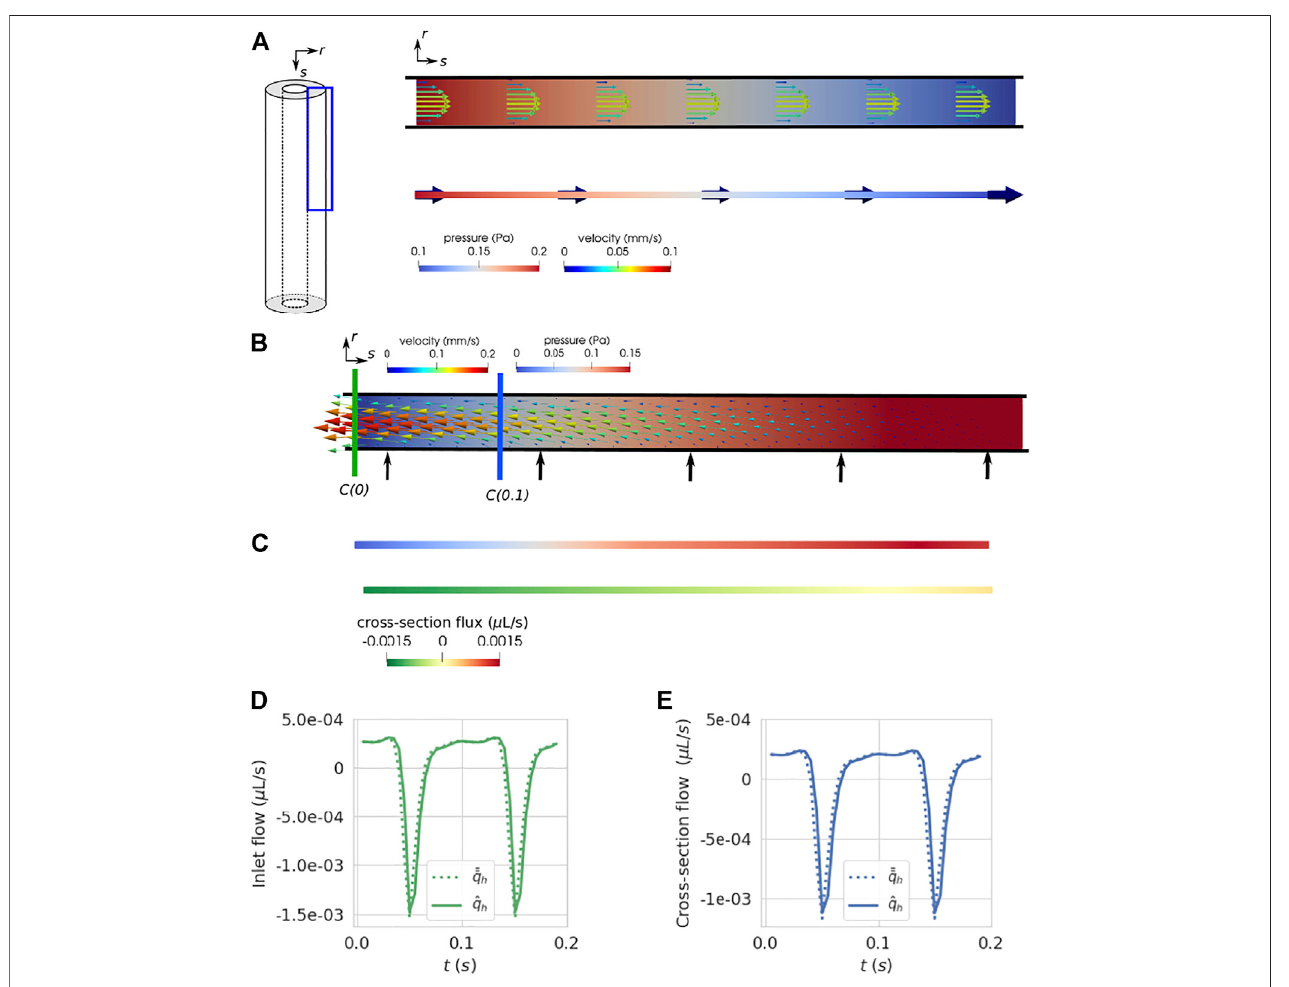
FIGURE2| PVS fl uxandpressureinanaxisymmetric annularcylinderinducedbyaconstantpressuredifferenceorcardiacwallmotion(ModelsA1,A2). (A) Model A1: A constant pressure gradient induces annular Poiseuille fl ow in both the full axisymmetric model (upper panel) and the reduced model (lower panel): snapshot of steadysolutionat T =0.1. (B – E) ModelA2:Innerwallpulsationsinducebidirectionalandoscillatory fl ow. (B) Snapshotofthefullmodelsolutionsatpeakout fl ux( t =0.05). Different cross-sections are marked in green (at the inlet) and blue (in the interior). (C) Pressure (upper panel) and cross-section fl ux (cid:2) q h (lower panel). (D) Cross- section fl ux predicted by the full model (dotted line) and the reduced model (solid line) at inlet versus time. (D) As for (C) but at the interior cross-section marked in (B) .